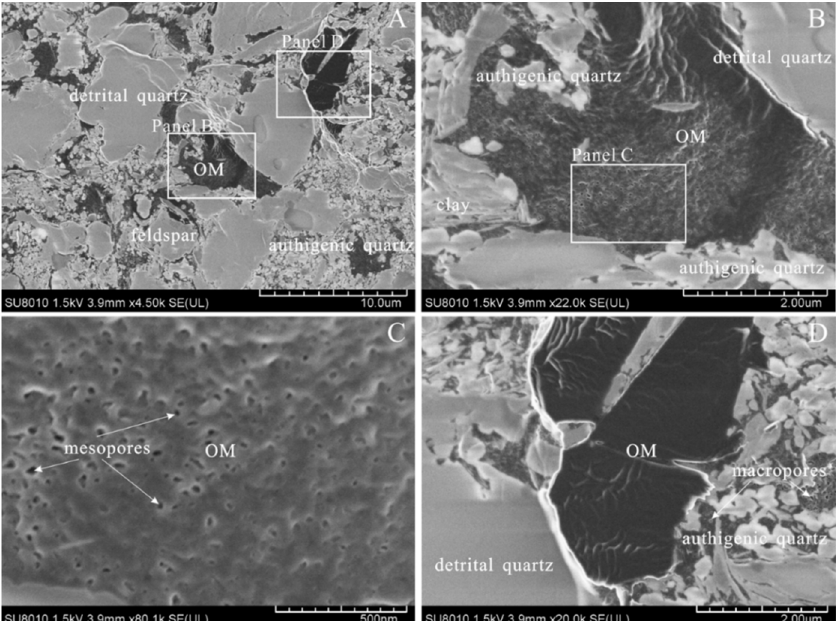
Figure 11. Field emission scanning electron microscopy (FE-SEM) images of the Niutitang shale sample DQC-9 (TOC = 9.54 wt.%, quartz = 47.3%, clay = 25.1%, excess SiO 2 = 19.45%). ( A ) Interparticle pores between clastic grains are mainly filled up by organic matter (OM) and authigenic quartz, and clay minerals are scattered sporadically. ( B , C ) Certain OM patches have a large number of resolvable mesopores with poor connectivity. ( D ) Certain OM patches lack distinguishable organic pores, whereas some organic matter that fills up the aggregates of authigenic microcrystalline quartz contains various types of mesopores and macropores.